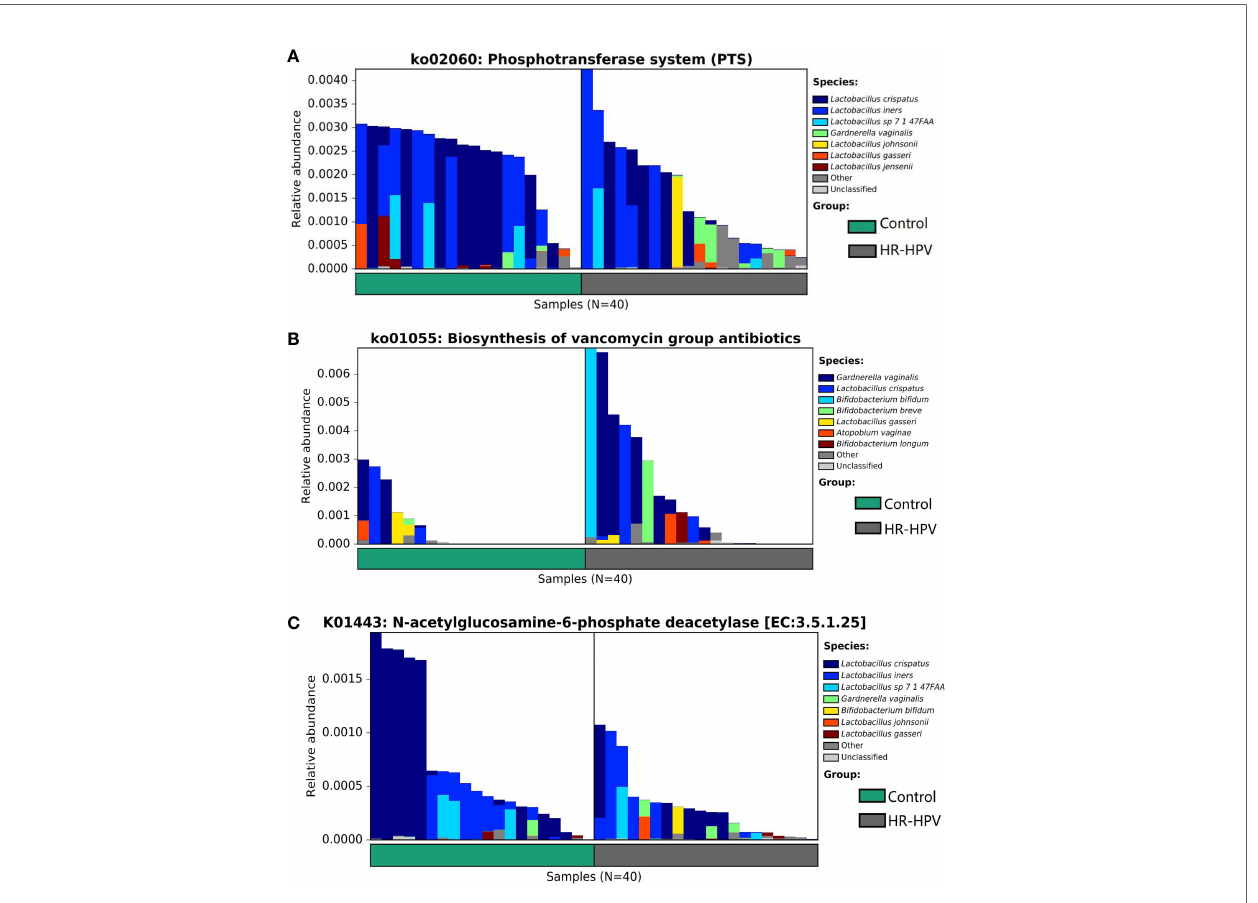
FIGURE 4 | The analysis of functional annotation of the KEGG database combined with the relative abundance of cervical microbiota. (A) Analysis of the species contribution degree of ko02060 (B) Analysis of the species contribution degree of ko01055 (C) Analysis of the species contribution degree of